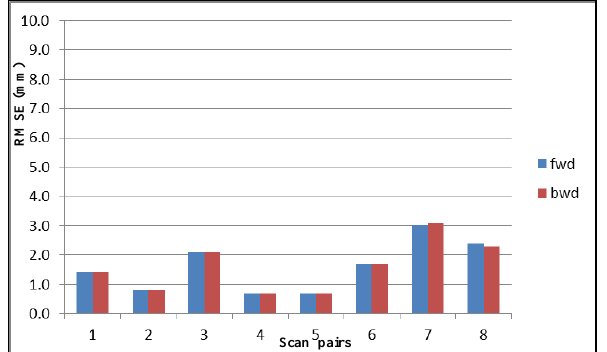
Figure 5. P2P registration RMSE (mm) for the eight scan pairs. Table 2. Statistics on RMSE differences (in mm).